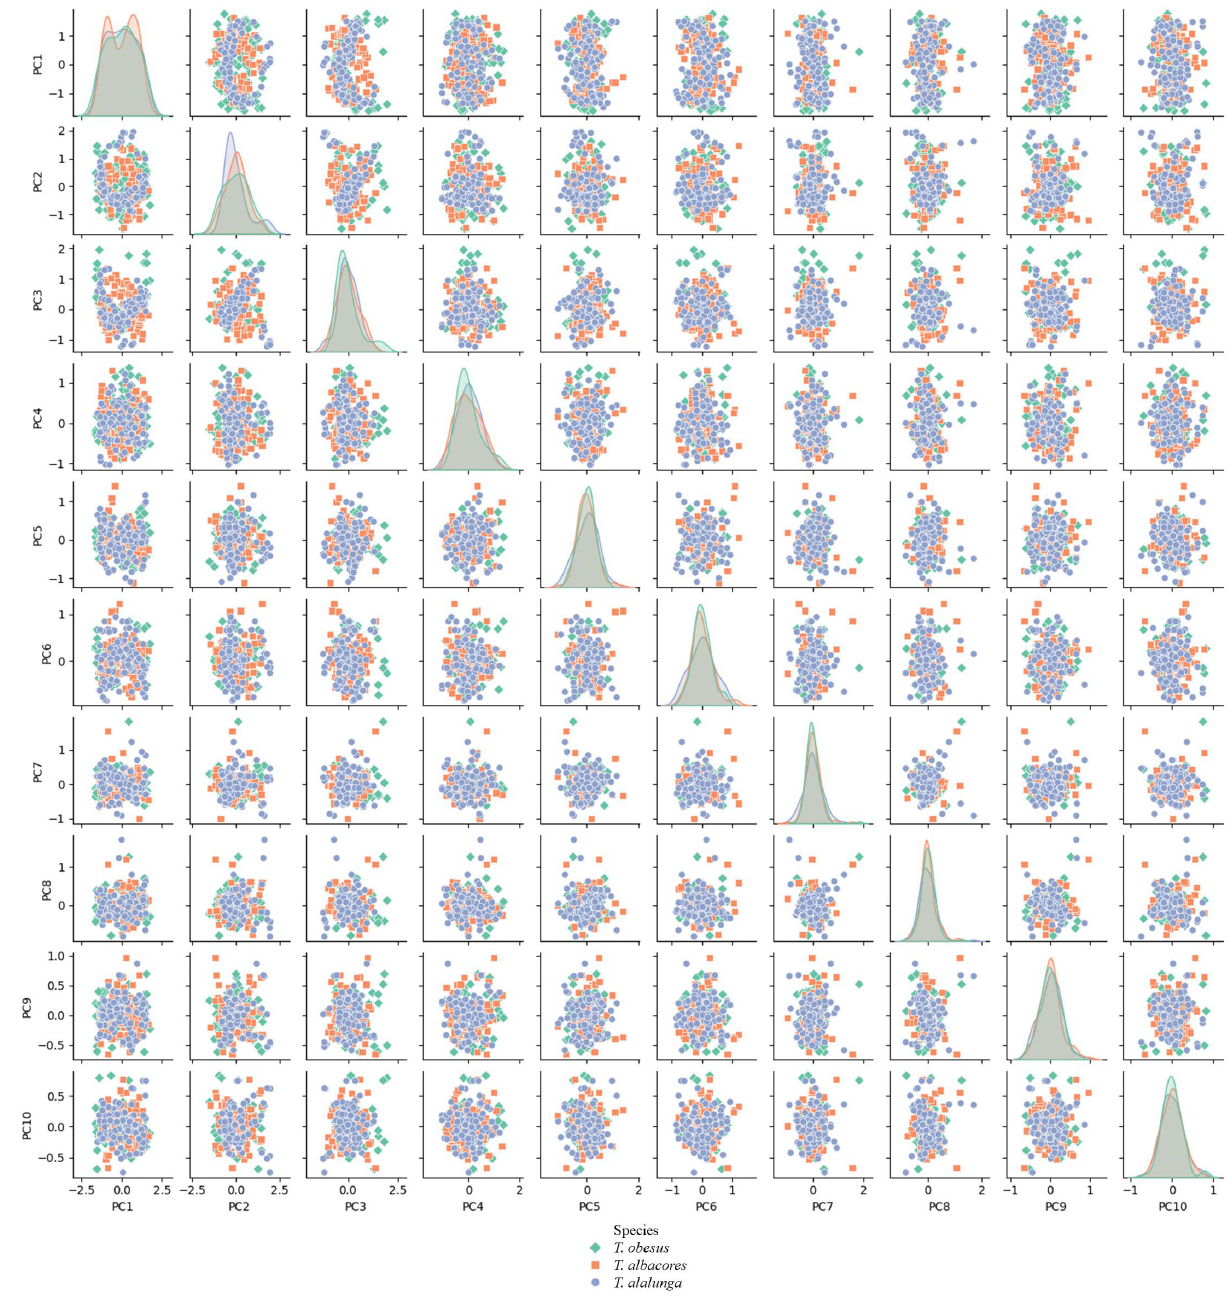
Figure 5. Principal component analysis of EFT features: the principal component had 100 tuna for each species.